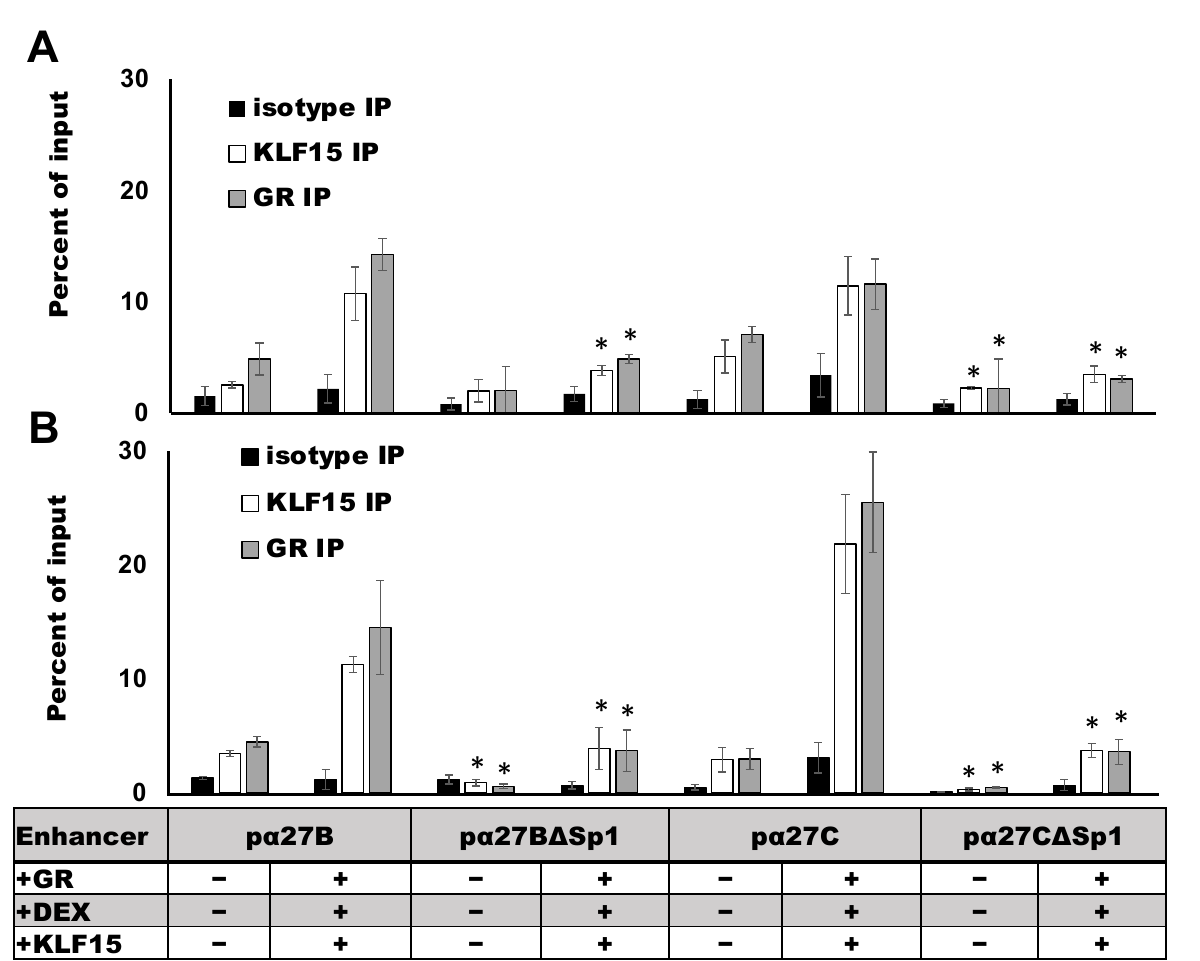
Figure 7. GR and KLF15 occupy ICP27 enhancer sequences. Neuro-2A (Panel ( A )) and Vero cells (Panel ( B )) were cultured in MEM containing 2% stripped FBS and transfected with the denoted enhancer constructs (4 µg, Figure 4A). Certain samples were co-transfected with GR (3 µg DNA) and KLF15 (3 µg DNA). Empty vector was added to maintain the same amount of DNA in each transfection. At 24 h post transfection, samples were treated with DEX (10 µM). At 48 h post transfection, ChIP was performed. DNA–protein complexes were immunoprecipitated with GR (5 µg) or KLF15 (5 µg) antibodies. Non-specific isotype IgG was used as a negative control. Immunoprecipitated DNA was purified, amplified by PCR, and run on a 2% agarose gel and then stained with ethidium bromide to visualize the PCR products. Primers for PCR are described in Figure 2C. Relative enrichment of DNA in the antibody samples was measured using image lab software (Biorad; Hercules, CA, USA) and presented as a percentage of input (13.3% of total cell lysate). Data represent the means of 3 separate experiments, and error bars indicate the standard error. Asterisks ( * ) denote a significant difference in DNA amplification of the Sp1 binding site mutants compared to wt samples, as determined by Student’s t-test ( p < 0.05).